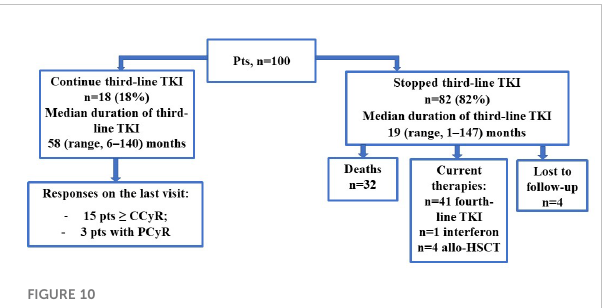
FIGURE 10 Long-term outcomes in the whole group on and after third-line